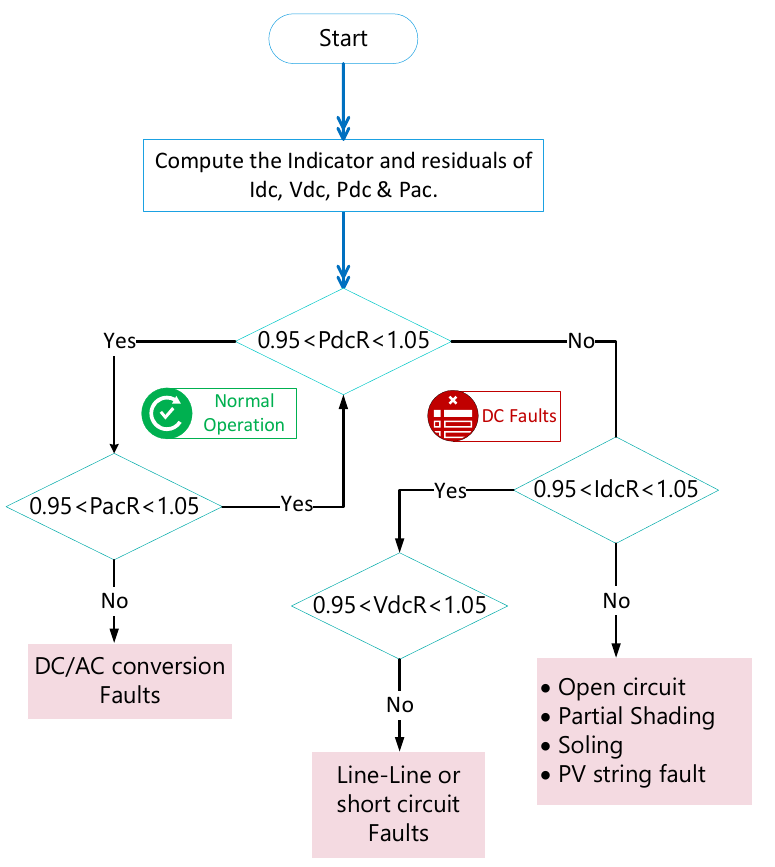
Figure 19. Flowchart of the developed strategy to detect and identify the DC and AC anomalies affecting the GCPVS.